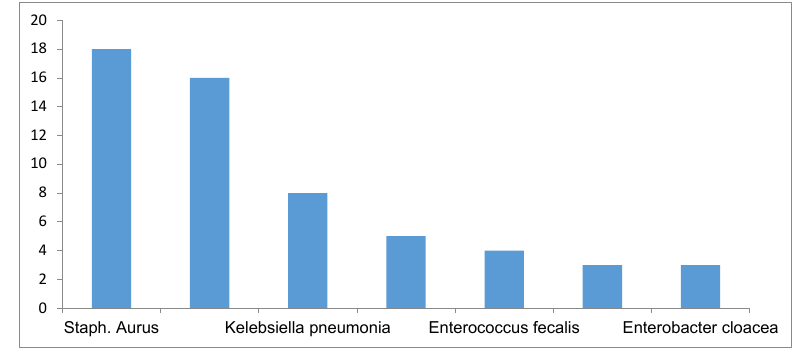
Figure 1. Common microorganisms responsible for infection of blue lumen.